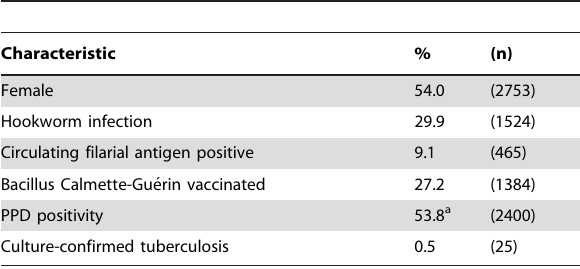
Table 1. Baseline Characteristics of Study Population